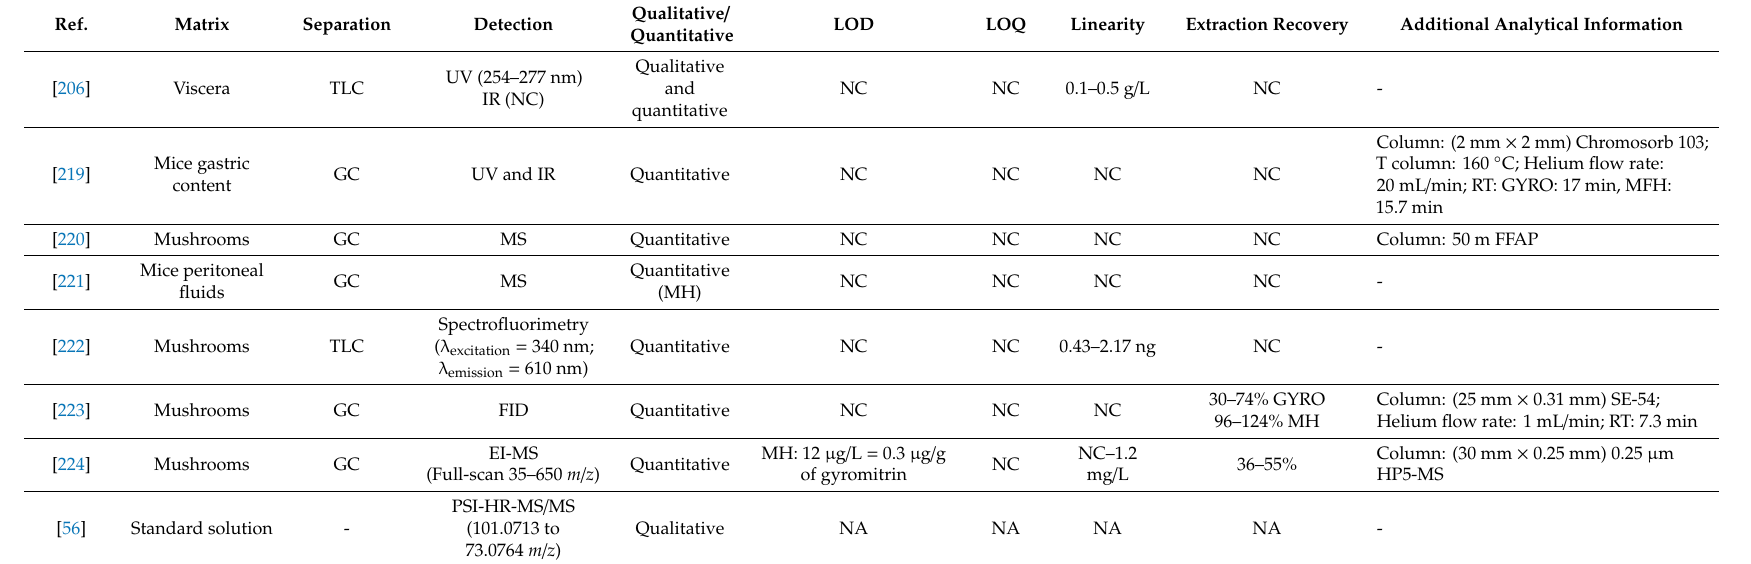
Table 9. Analytical methods for gyromitrine